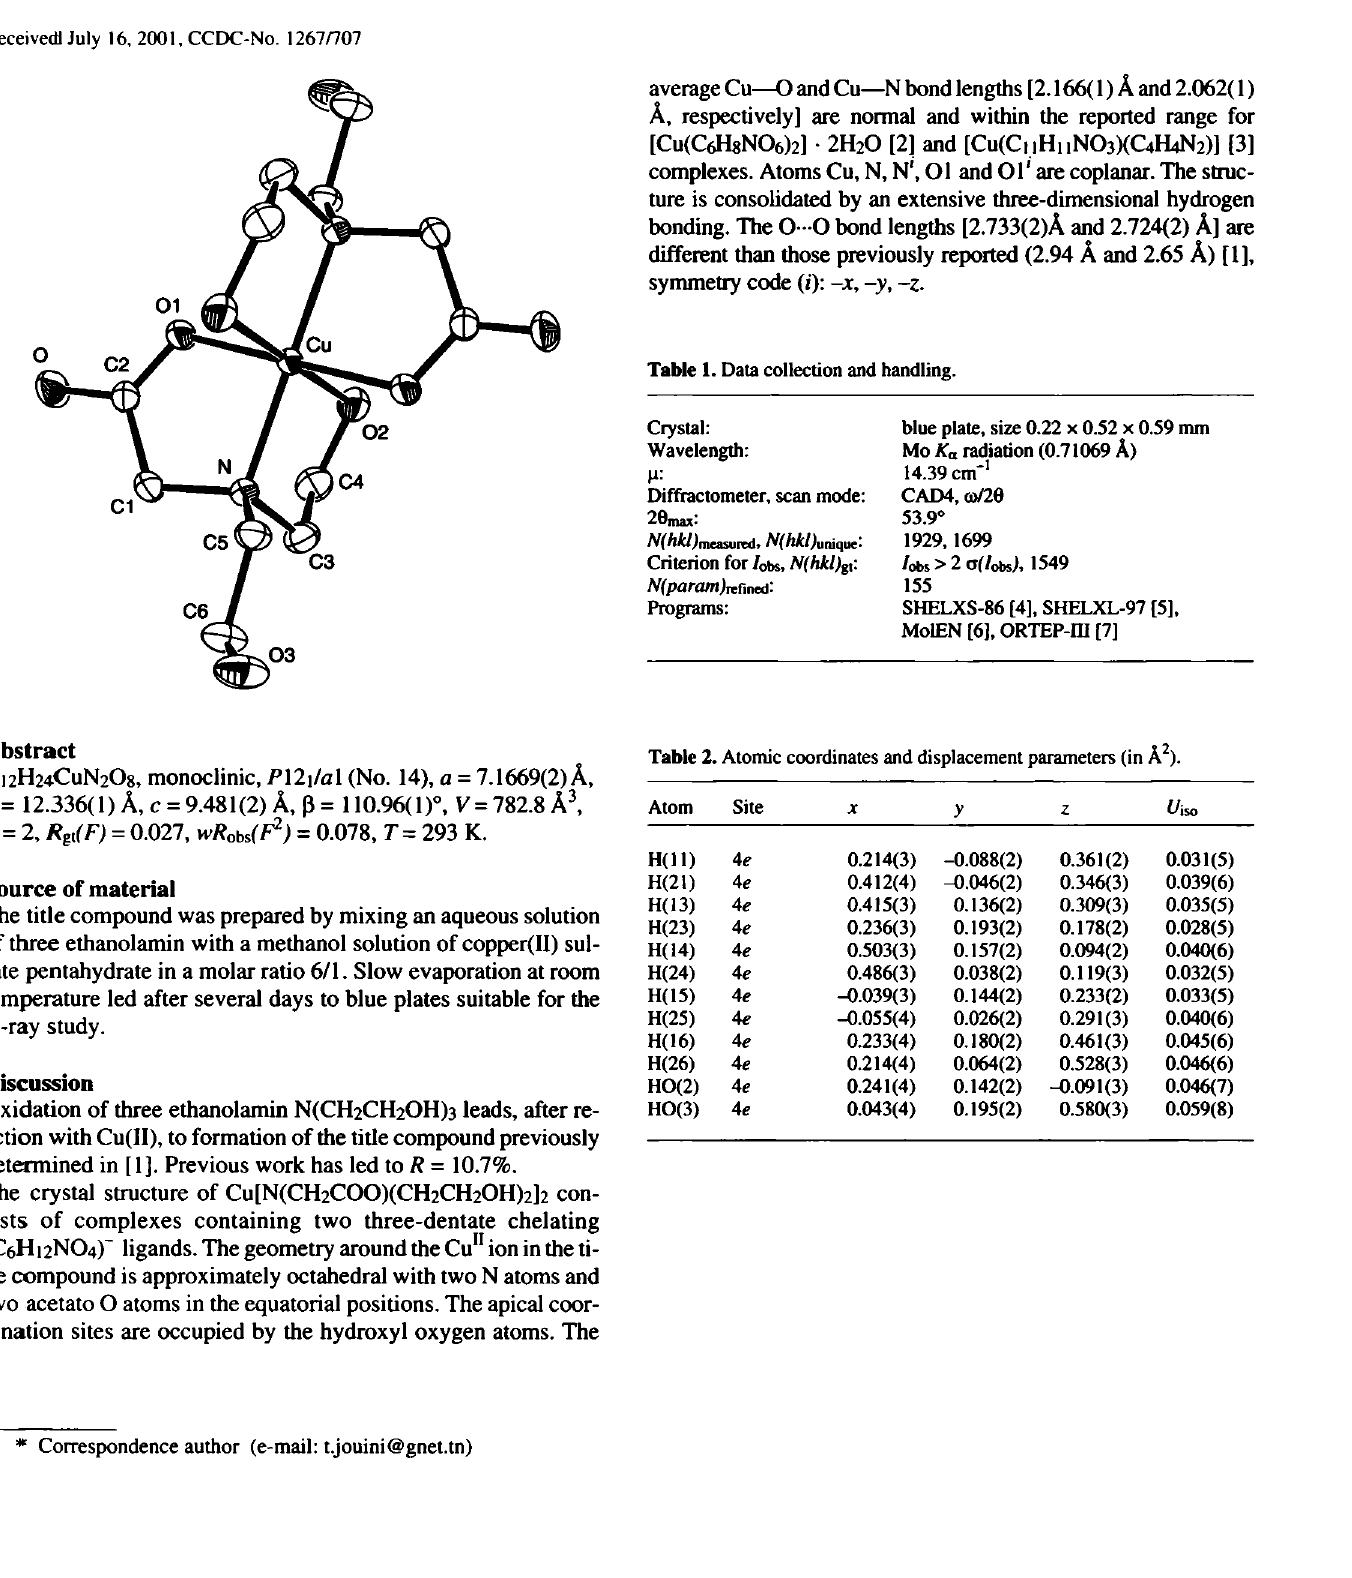
Table 1. Data collection and handling.